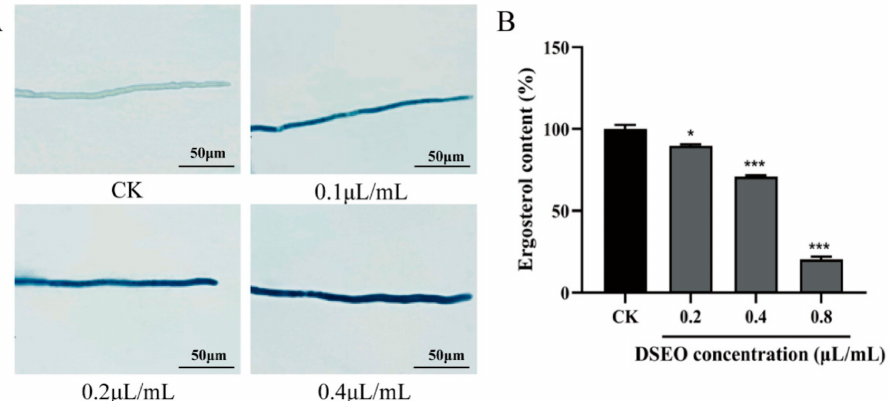
Figure 3. The effects of DSEO on the plasma membrane of N. parvum . ( A ) Mycelia were observed under the microscope after staining with Evans blue; ( B ) The effect of DSEO on the content of ergosterol of N. parvum after incubation at different concentrations of DSEO for 3 h. “CK” represents “control”. Statistical significance was set at * p < 0.05, *** p <